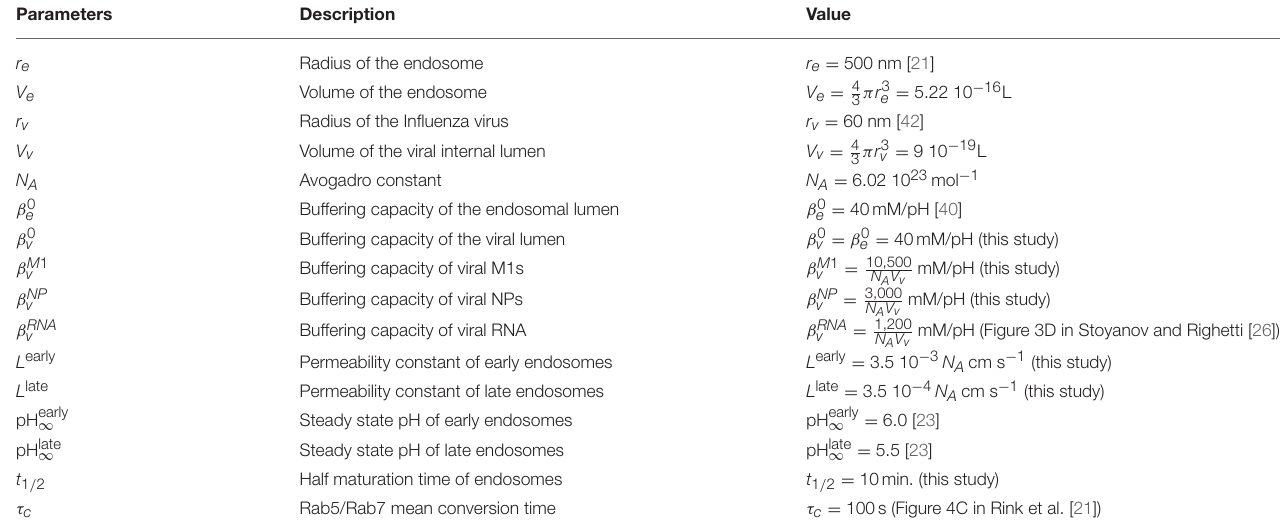
TABLE 1 | Parameters of the endosome acidification model. Parameters